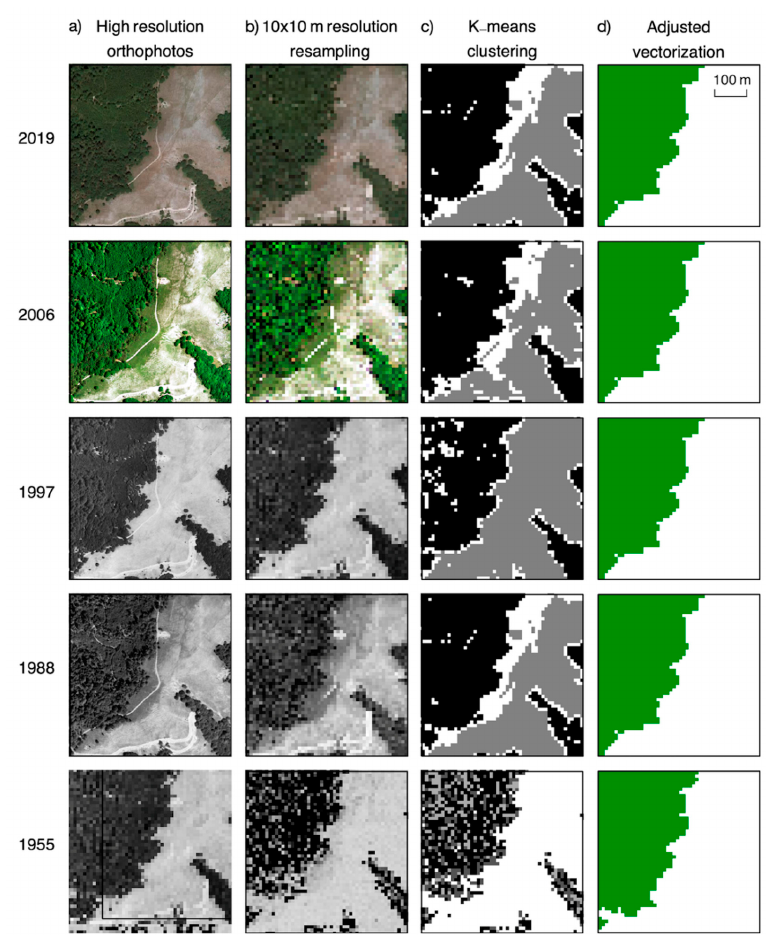
Figure 6. Woodland margin from 1955 to 2019. ( a ) High-resolution orthophotos. ( b ) Ten meter resolution images obtained via resampling, used for the K-means clustering ( c ). ( d ) Woodland margin and the area it covers in the considered square. The green area, which represents the extent of the beech forest, consists of 0.106 km 2 for 2019, 2006, 1997, and 1988, and of 0.104 km 2 for 1955.